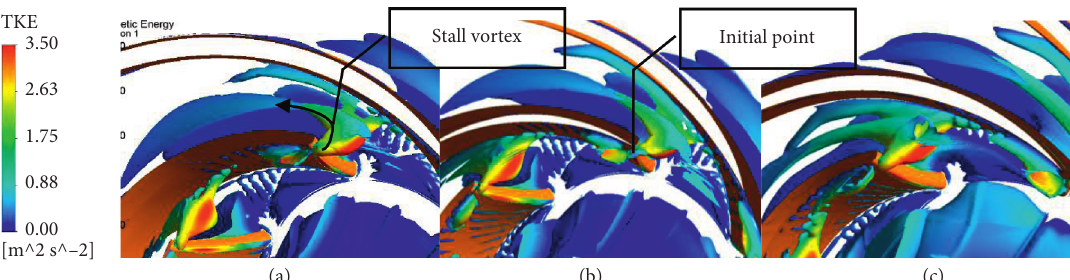
Figure 7: Vortex structure comparison of impeller inlet at different times at 0.4 Qd . (a) t � 360. (b) t � 340. (c) t � 320.